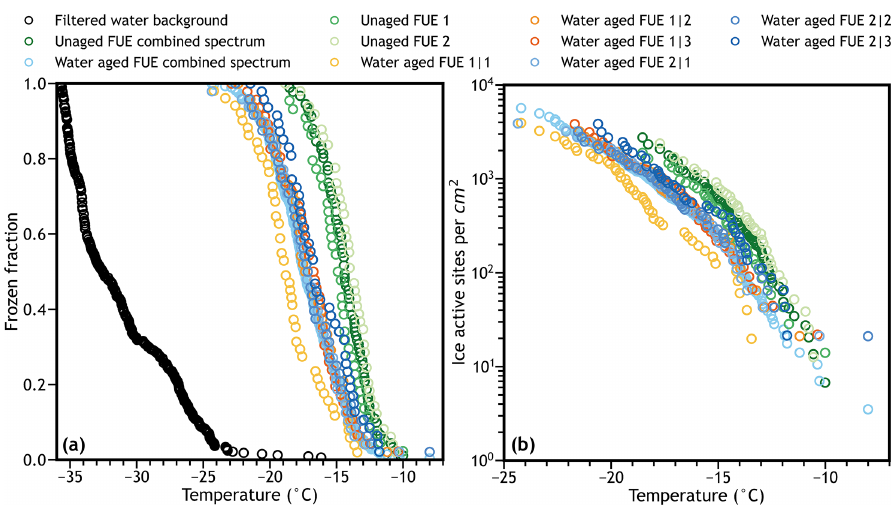
Figure 1. Raw (not interpolated or binned) and combined raw (a) frozen fraction and (b) surface area normalized ice nucleation active site density spectra for sample droplet freezing data used in this study. Water aged spectra are from two separate aging experiments with three freezing experiments each for a total of six individual water aged runs denoted by “experiment# | freezing